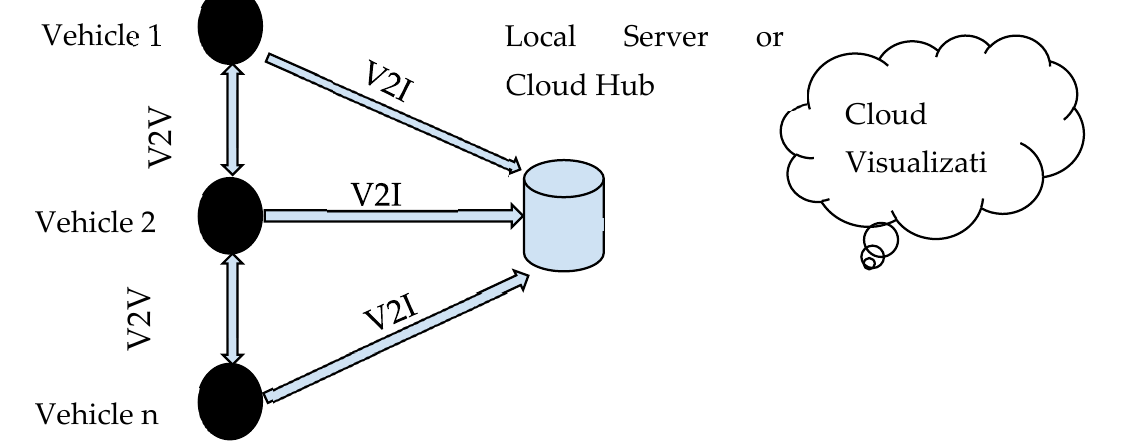
Figure 1. Overall system